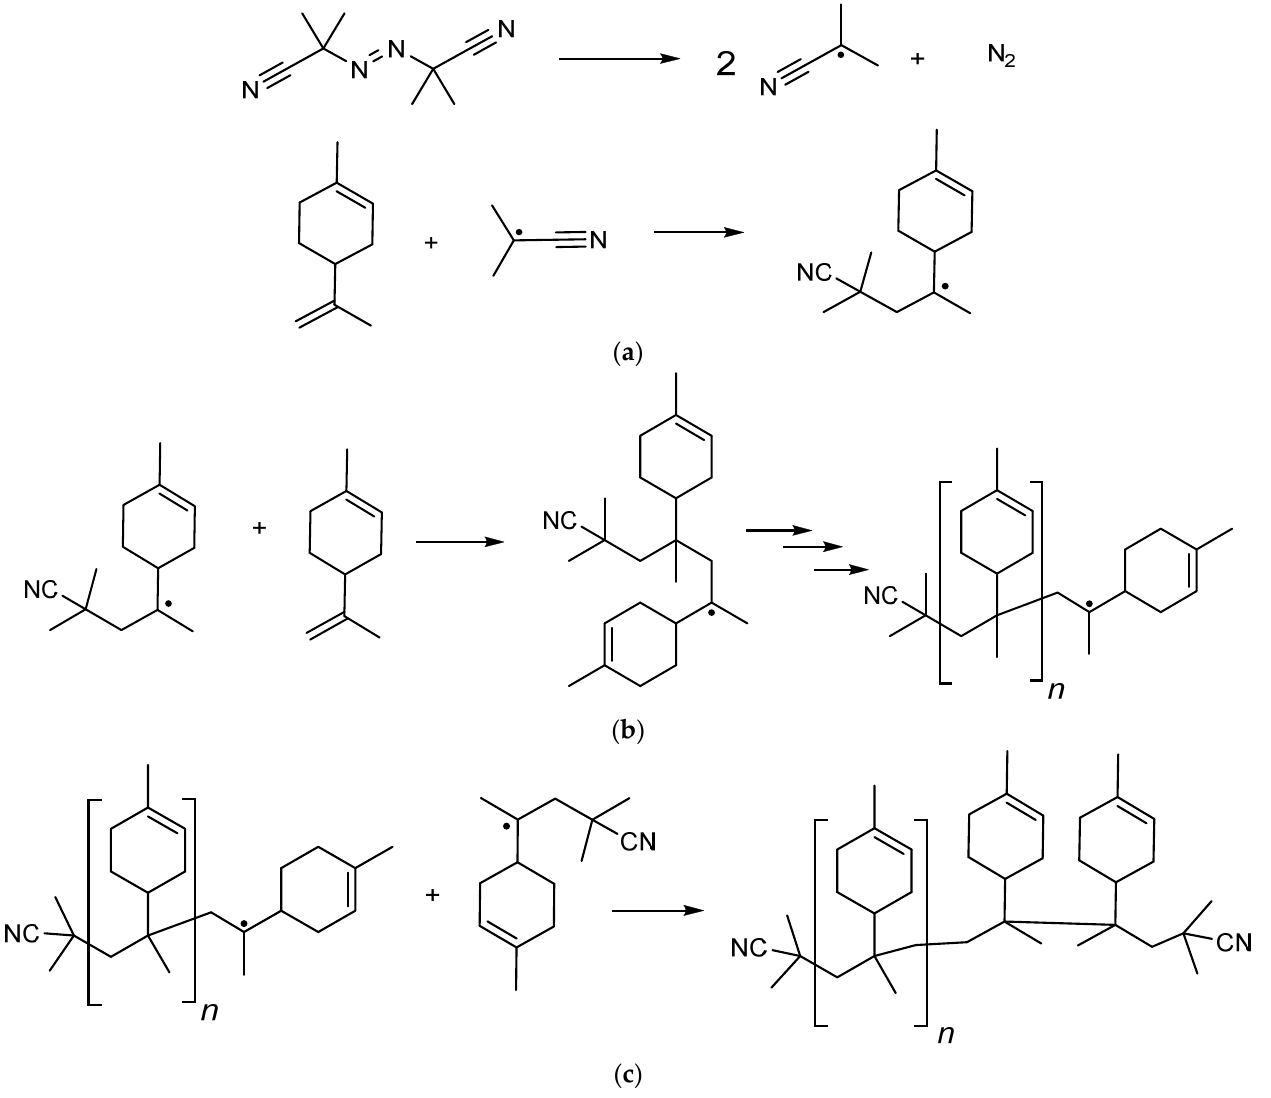
Figure 1. Reaction schemes of various stages of limonene radical polymerization: ( a ) initiation; ( b ) chain growth; ( c ) break.